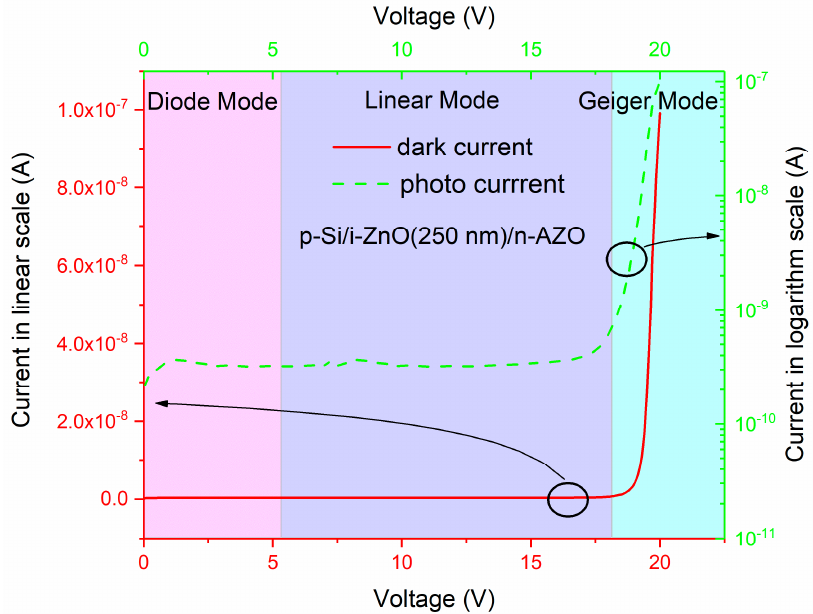
Figure 11. The typical I-V characteristics for our p-Si / i-ZnO / n-AZO avalanche photodiode; the green dashed line indicates the photo current, and the red solid line represents the dark current.